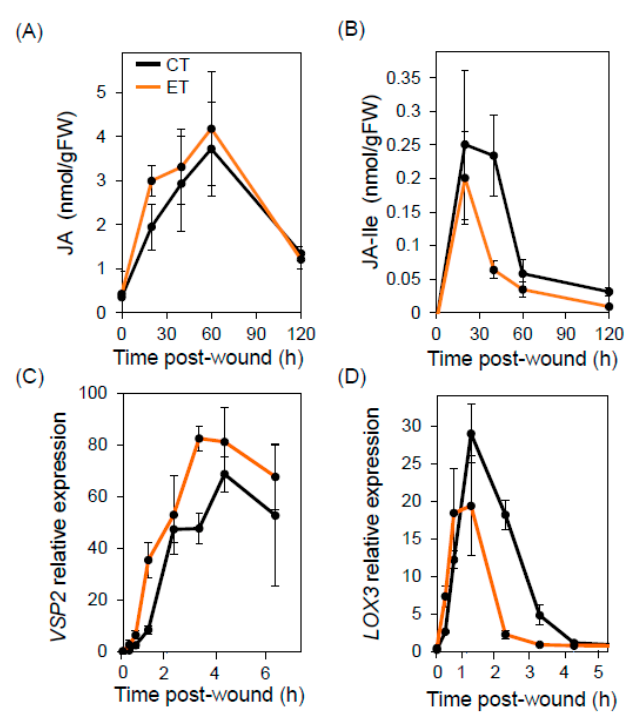
Figure 2. Elevated temperature conditions do not compromise wound responses. Plants were grown continuously at CT for 38 days prior to a 48-h acclimation period at either CT or ET. Following the acclimation period, three leaves of each plant were mechanically wounded with a hemostat. Wounded leaves were collected at the indicated times thereafter for analysis of hormone or gene expression levels. ( A , B ) Time course of wound-induced jasmonic acid (JA, A ) and JA-Ile ( B ) accumulation. The black and orange lines denote plants grown continuously at CT (22 ◦ C) and plants that were exposed to ET conditions (29 ◦ C) for two days prior to wounding, respectively. ( C , D ) Wound induction of the JA-responsive genes VSP2 ( C ) and LOX3 ( D ) in plants grown as described above. The data points denote the mean ± SE of three replicates containing tissue pooled from two plants.